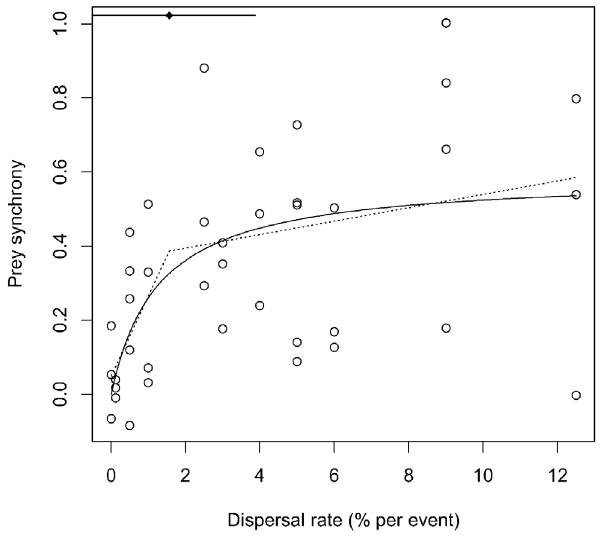
Figure 2. Prey synchrony vs. dispersal rate. Prey synchrony ( z - transformed cross-correlation of log 10 -transformed prey abundances) as a function of dispersal rate. Each open point gives results from one replicate pair of bottles. The solid curve is y = ax /( b + x ) with estimated parameters (95% likelihood profile c.i.) of a =0.59 (0.39, 1.25), b =1.27 (0.14,8.50). The curve y =[ ax /( b + x )][1 + (1- cx )e 2 cx ] with estimated param- eters (95% likelihood profile c.i.) of a =0.59 (0.45, 1.26), b =1.22 (0.45, 8.62), c =14.66 (14.66, 44.64) is hidden by the solid curve. The dotted curve is a piecewise linear regression. The black diamond indicates the estimated location and 95% confidence interval for the discontinuity of the dotted curve. See [34] for review of the concept of profile confidence